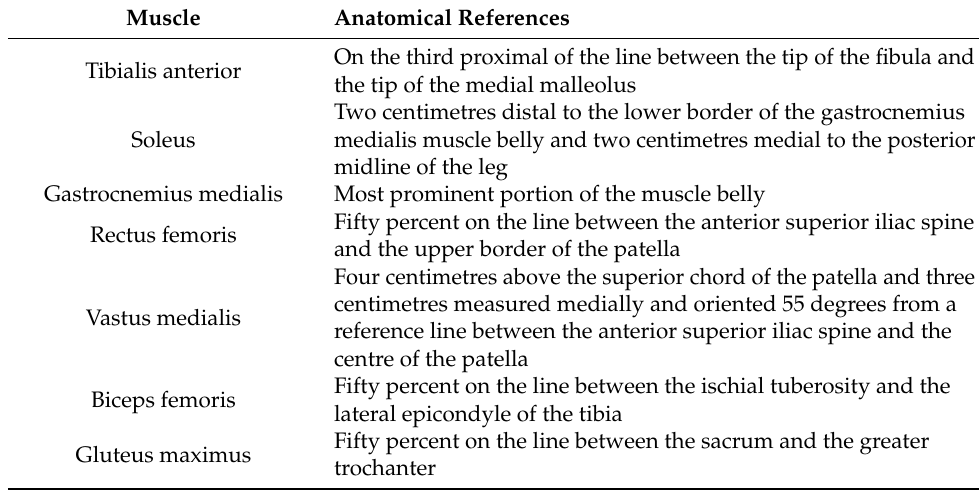
Table 2. Anatomical references for the electrode placement